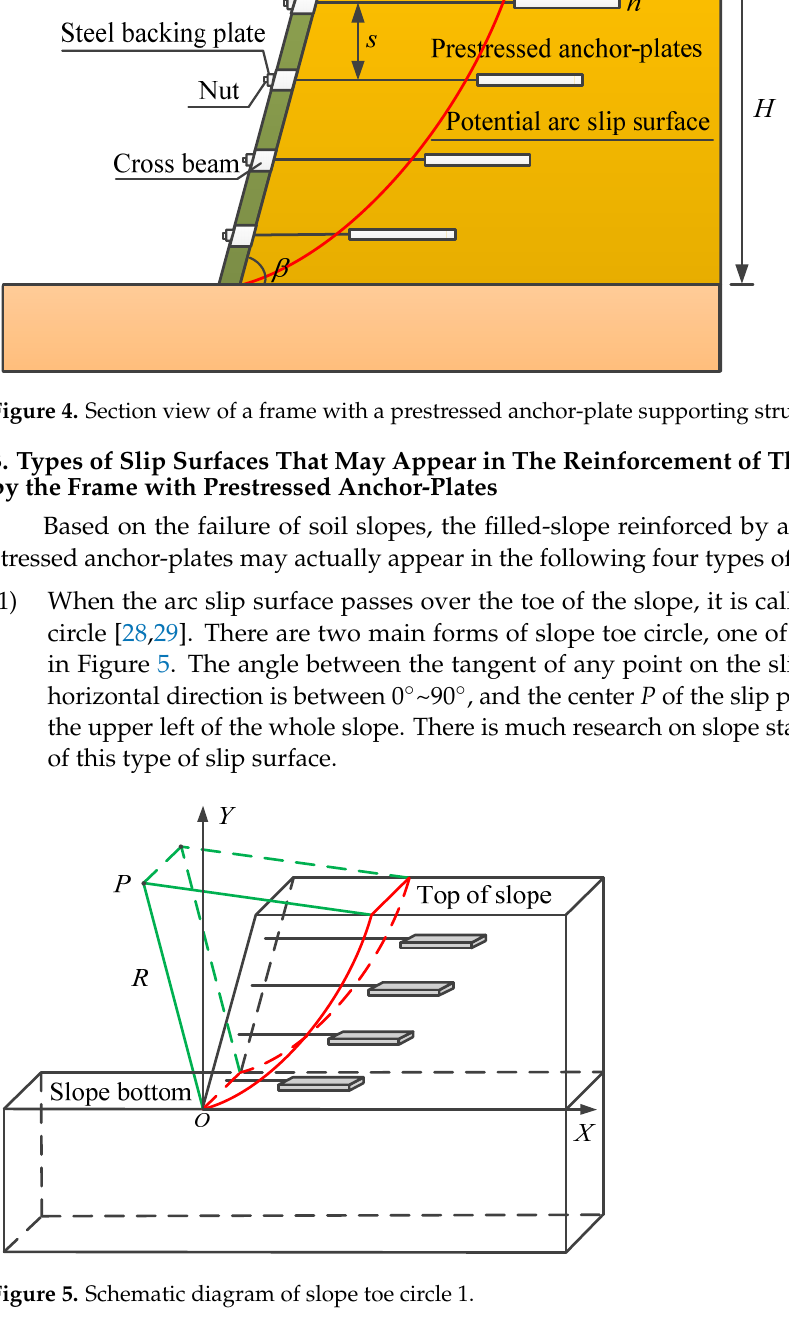
Figure 5. Schematic diagram of slope toe circle 1.